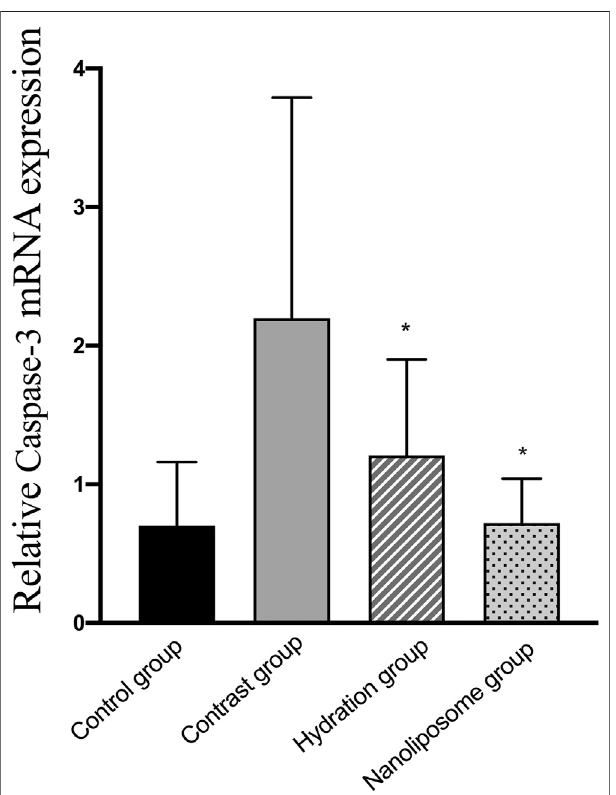
FIGURE 9 | The relative mRNA expression of target gene was detected by Real-time PCR. Real-time PCR was used to validate the change in the expression of the Caspase-3 gene identi fi ed in four groups. Caspase-3 (cid:2) cysteine aspartate speci fi c protease 3. Values are expressed as mean ± SD. *Compared with the contrast group, p < 0.05. **Compared with the contrast group, p < 0.01. # Compared with the hydration group, p < 0.05. ## Compared with the hydration group, p < 0.01.